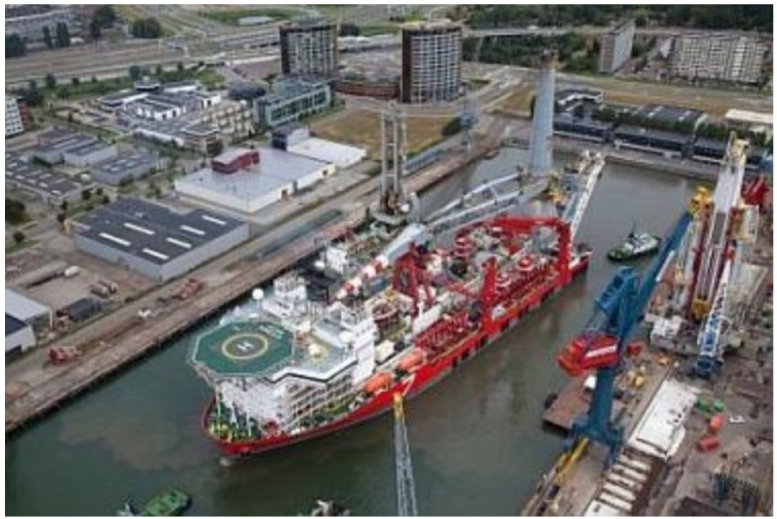
Figure 13. Application of heavy offshore steel plates S355G10+M and S355G8+M for the offshore crane OSA Goliath (Courtesy: Oakley Steel).